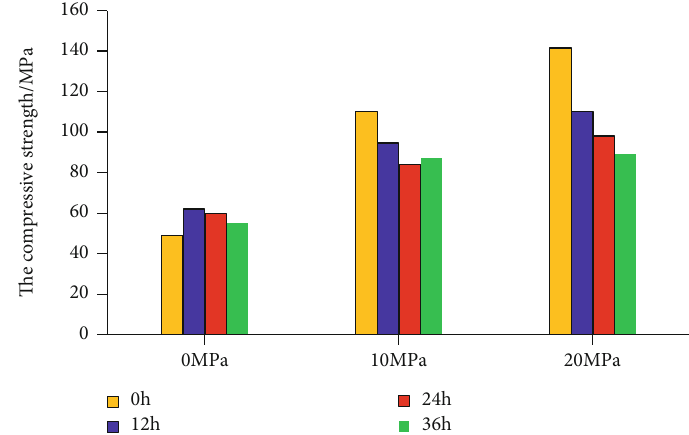
Figure 10: Strength of the middle-deep transition shale matrix after drilling fl uid soaking.